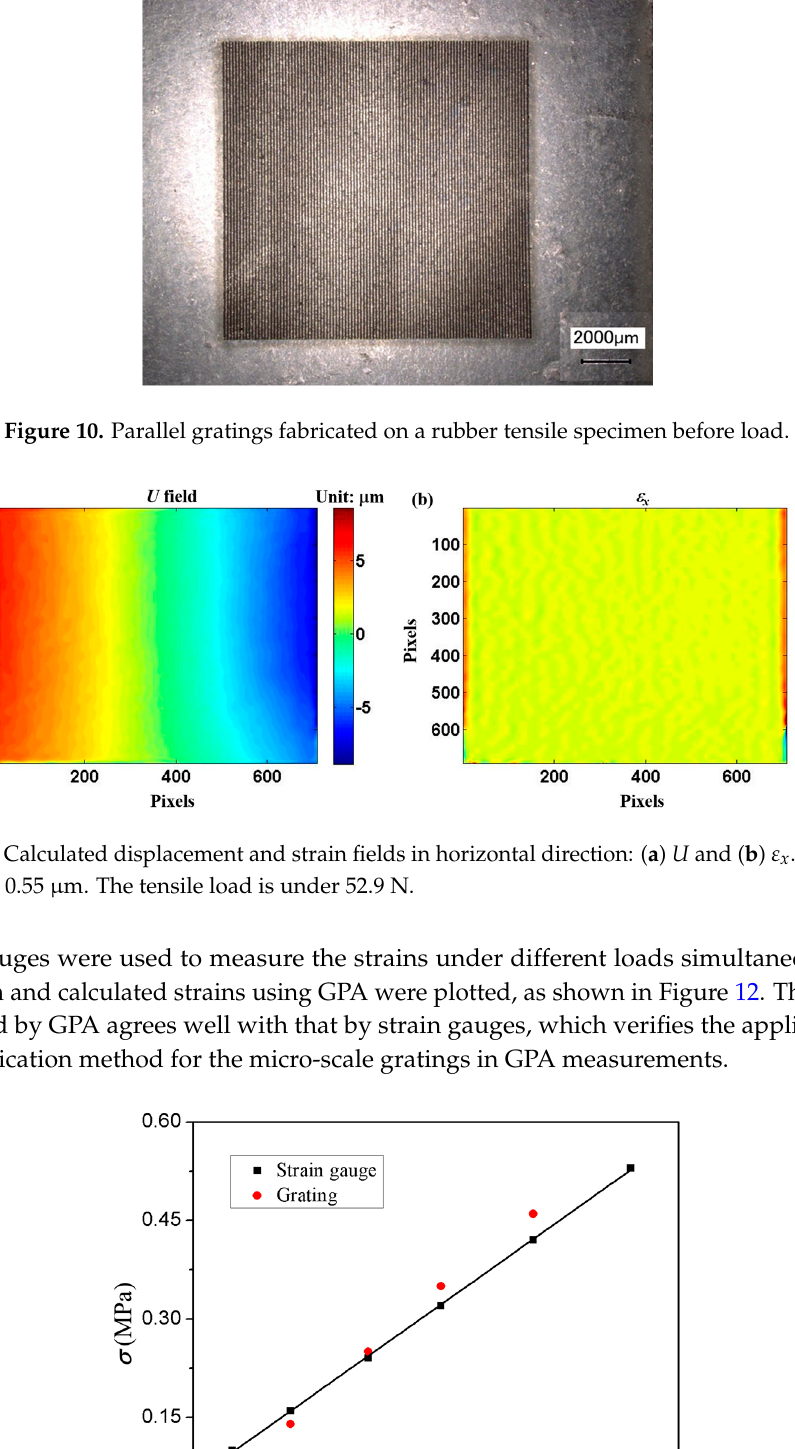
Figure 12. Stress-strain relation measured by strain gauge and gratings.